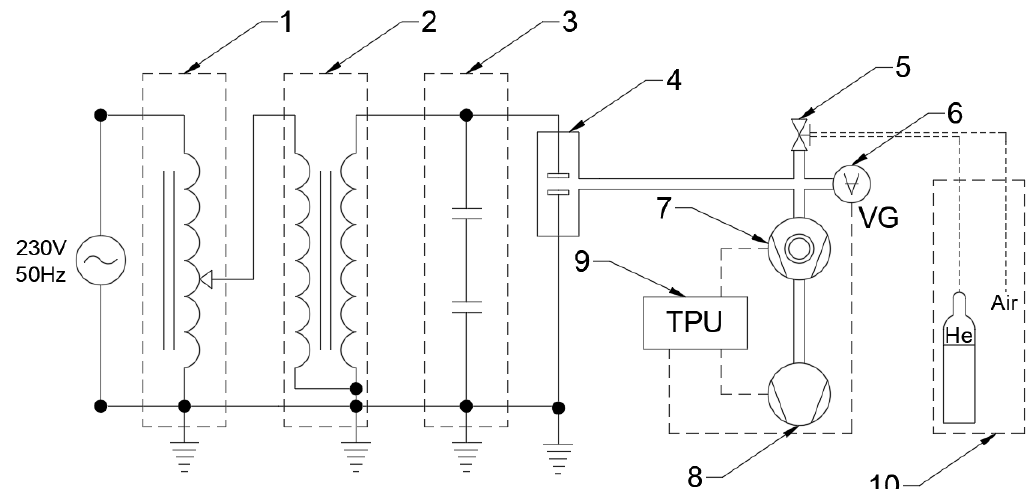
Figure 4. Scheme of test system for testing dielectric strength of MV vacuum interrupters (1—control panel, 2—power transformer, 3—capacitance divider, 4—vacuum interrupter under test, 5—manual dosing valve, 6—vacuum gauge, 7—turbomolecular pump, 8—rotary pre-pump, 9—system controller, 10—technical gases dosed to the inside of the tested object).